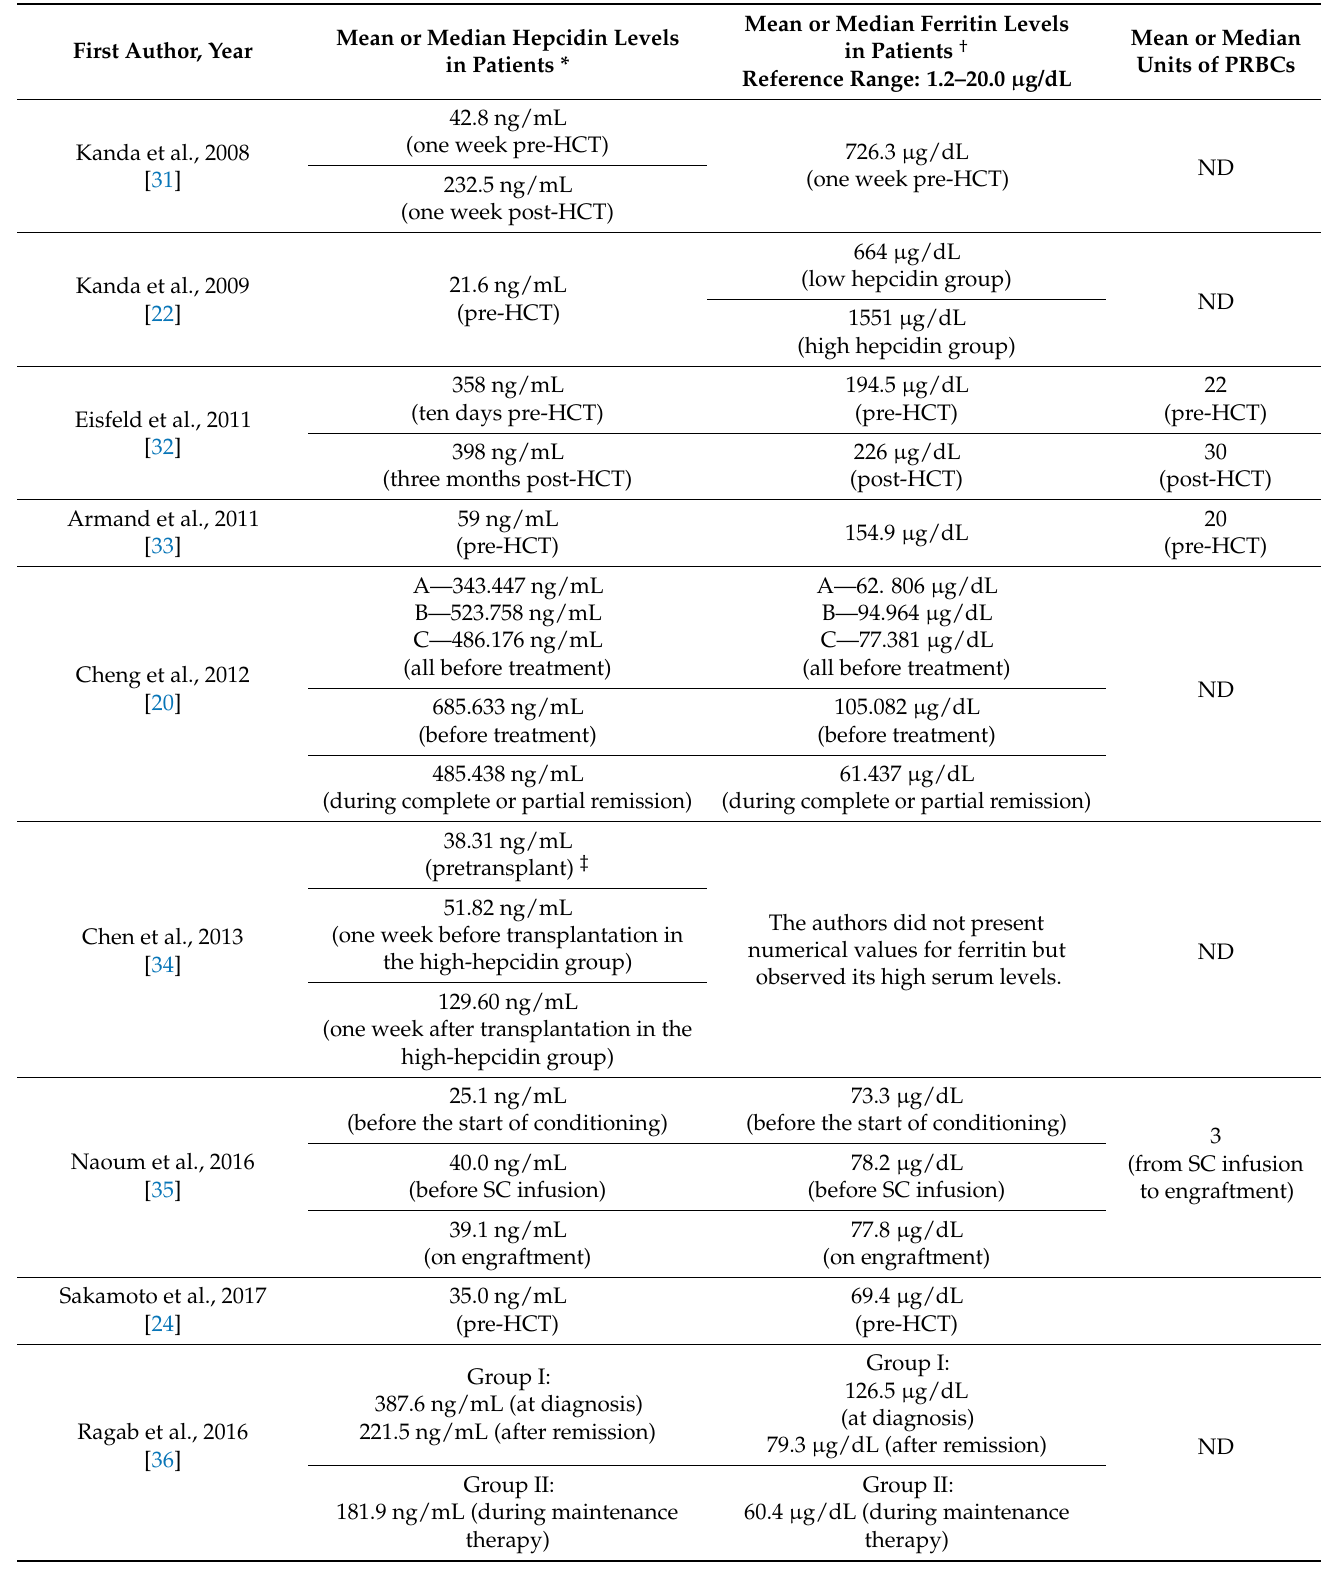
Table 3. The blood hepcidin levels reported in patients with AL/HCT on the background of serum ferritin levels and packed red blood cells